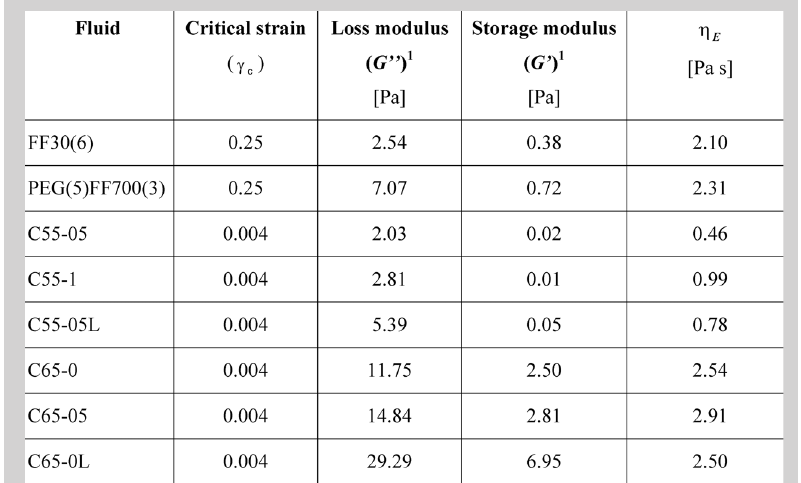
Table 3: Dynamic data at 1 Hz and apparent extensional viscosity data evaluated at = 4200 s -1